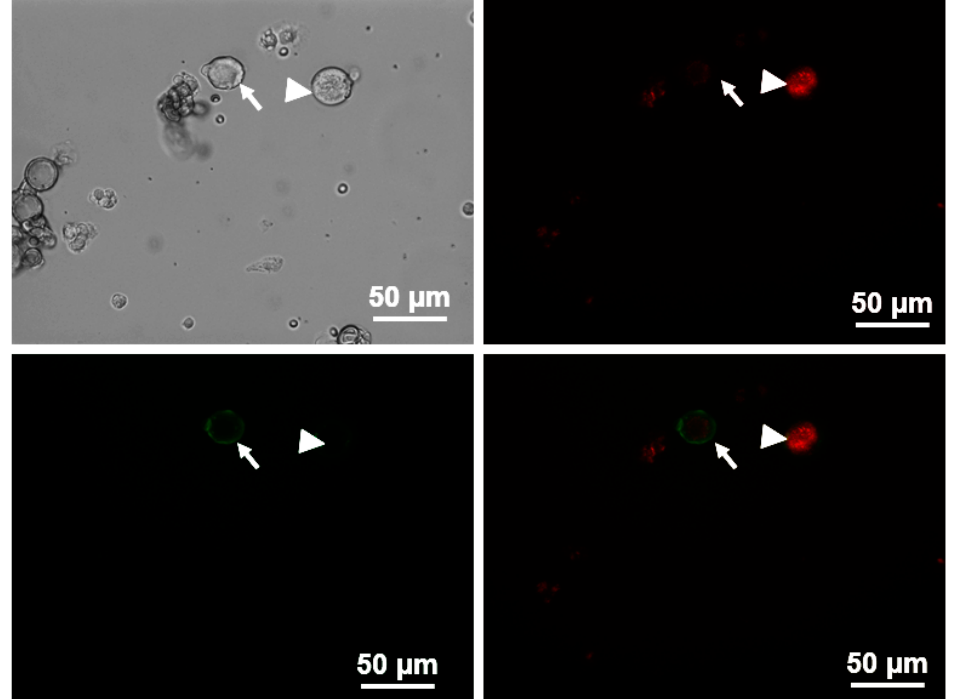
Figure 4. Representative images showing how to identify the medium-sized IB4-negative muscle afferents neurons in dorsal root ganglion (DRG) during patch-clamp experiments. In the top panel, DiI-labeled muscle afferents DRG neurons with red color in fluorescent light (right) and cells in the same field under regular light (left). In the bottom panel, Isolectin B4 (IB4, green color) was used to further separate muscle afferents DRG neurons into two groups: IB4-positive neurons (pointed by white arrow) and IB4-negative neurons (pointed by white arrow head). Digitally merged images from top right panel and bottom left panel are displayed in bottom right panel.